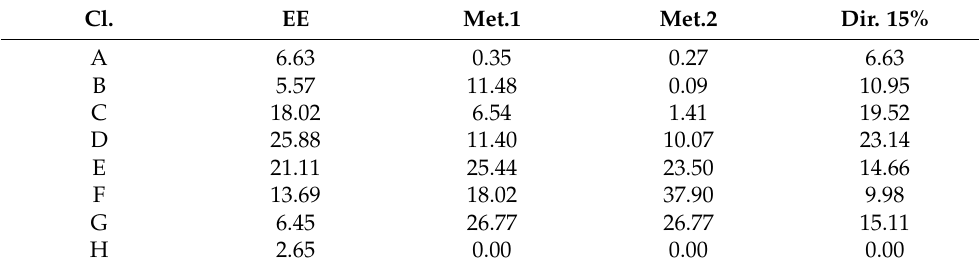
Table A5. EPC certificates % per energy class, as allocated by the different methods, educational.